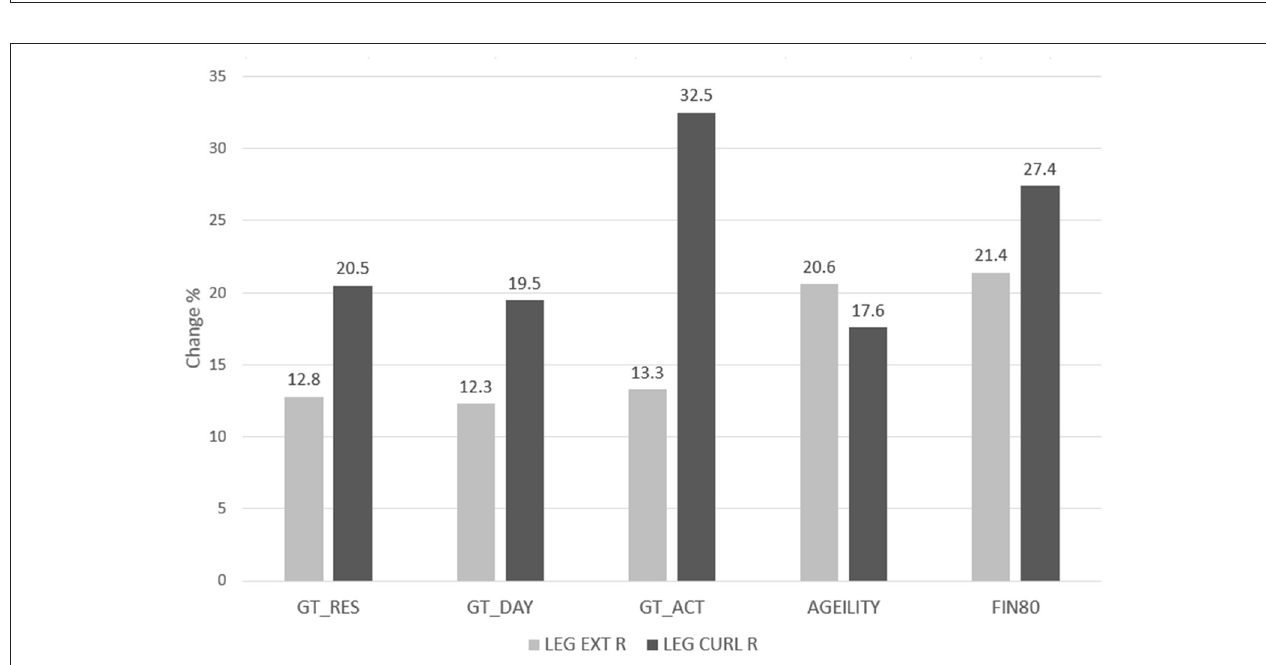
were comparable to those reported in meta-analysis of research studies by for example, Lopez et.al., observing increases of 6.6– 37% in maximal strength of strength training and multimodal training (40), and Peterson reporting an average of 33%